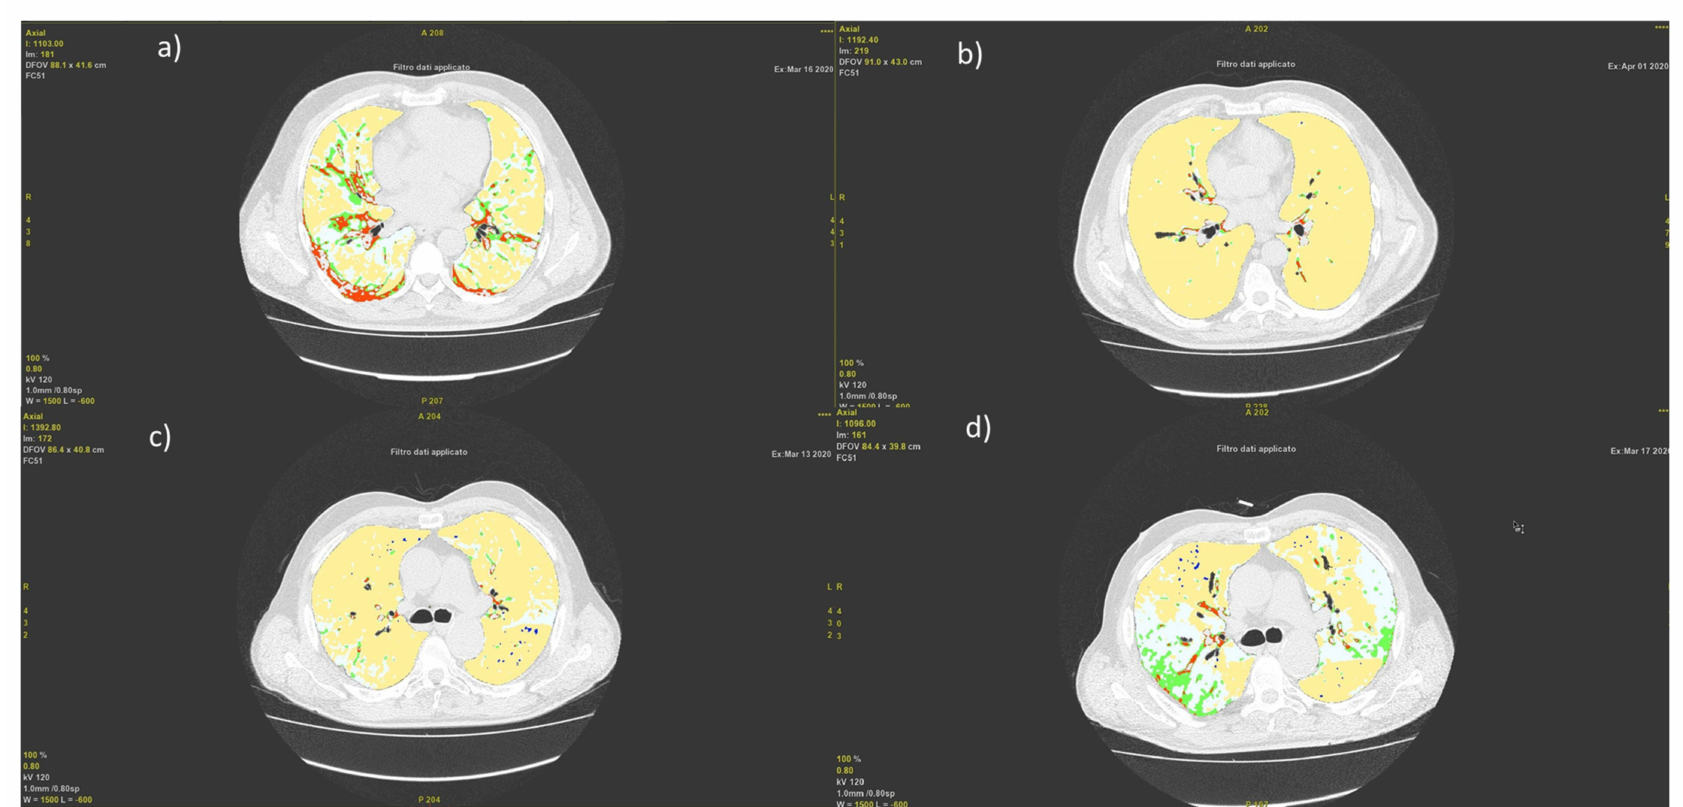
Figure 4. Representative cases of a patient with a CT panel improved and then discharged ( a ) and ( b ) (at baseline and follow-up CT), and of a case of a patient with a CT panel worsened and then died ( c ) and ( d ) (at baseline and follow -up